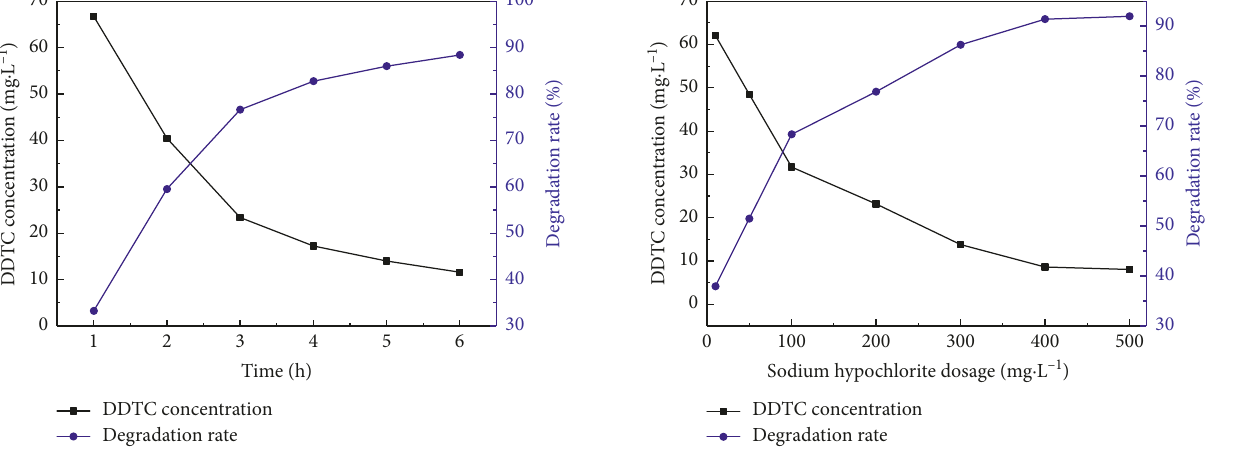
Figure 6: Influence of the dosage of sodium hypochlorite on the degradation of DDTC.